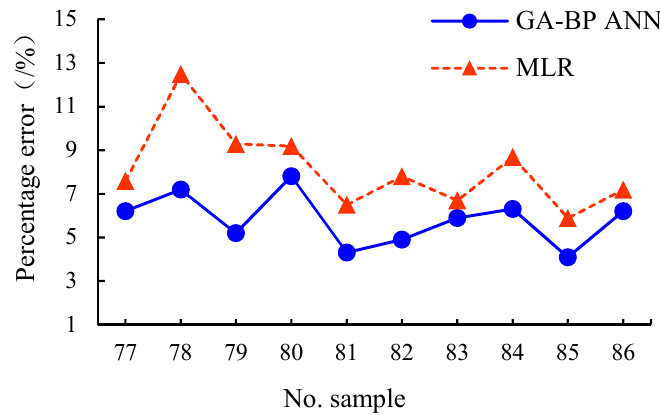
Figure 17. Comparison of the percentage error between the actual scores and the predicted values of the two models. MLR, multiple linear regression.